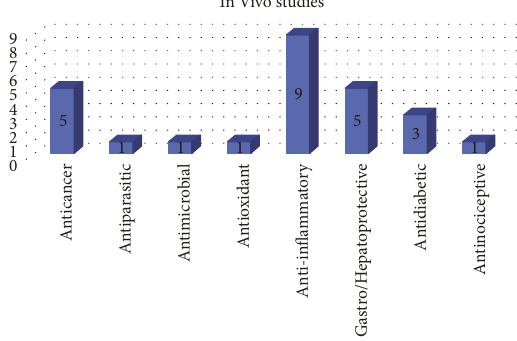
Figure 6: Quantification and classification of in vivo studies